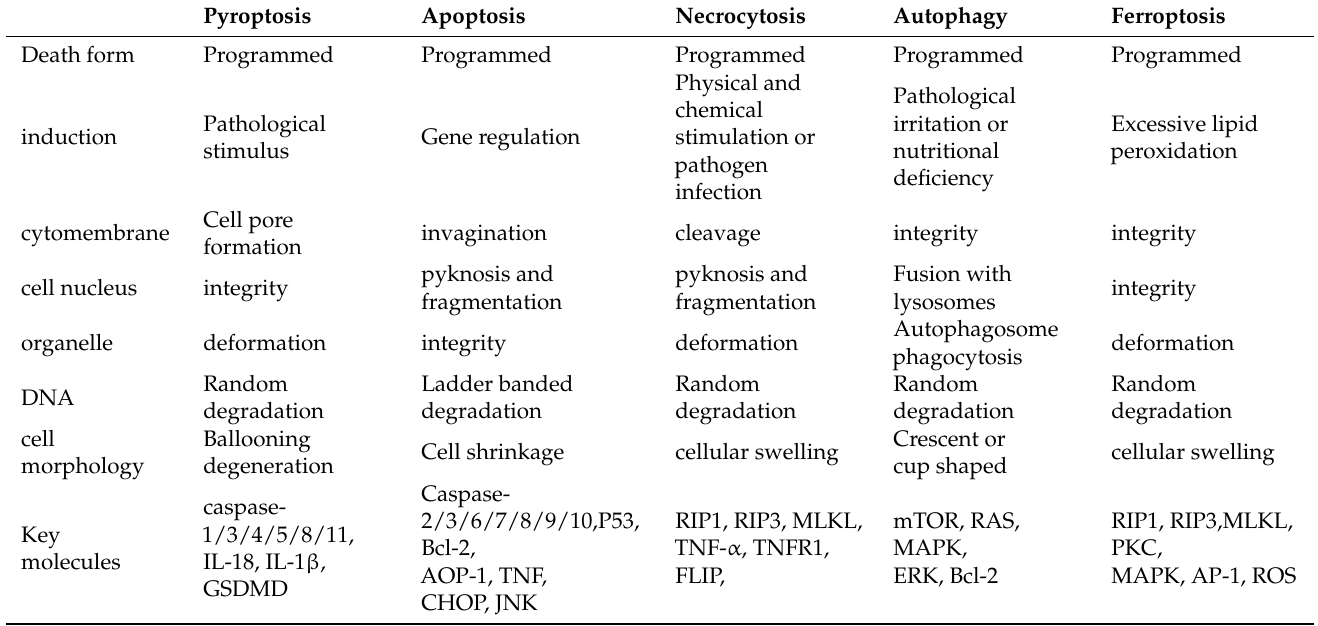
Table 1. Summary of studies on the difference between pyroptosis and other types of cell